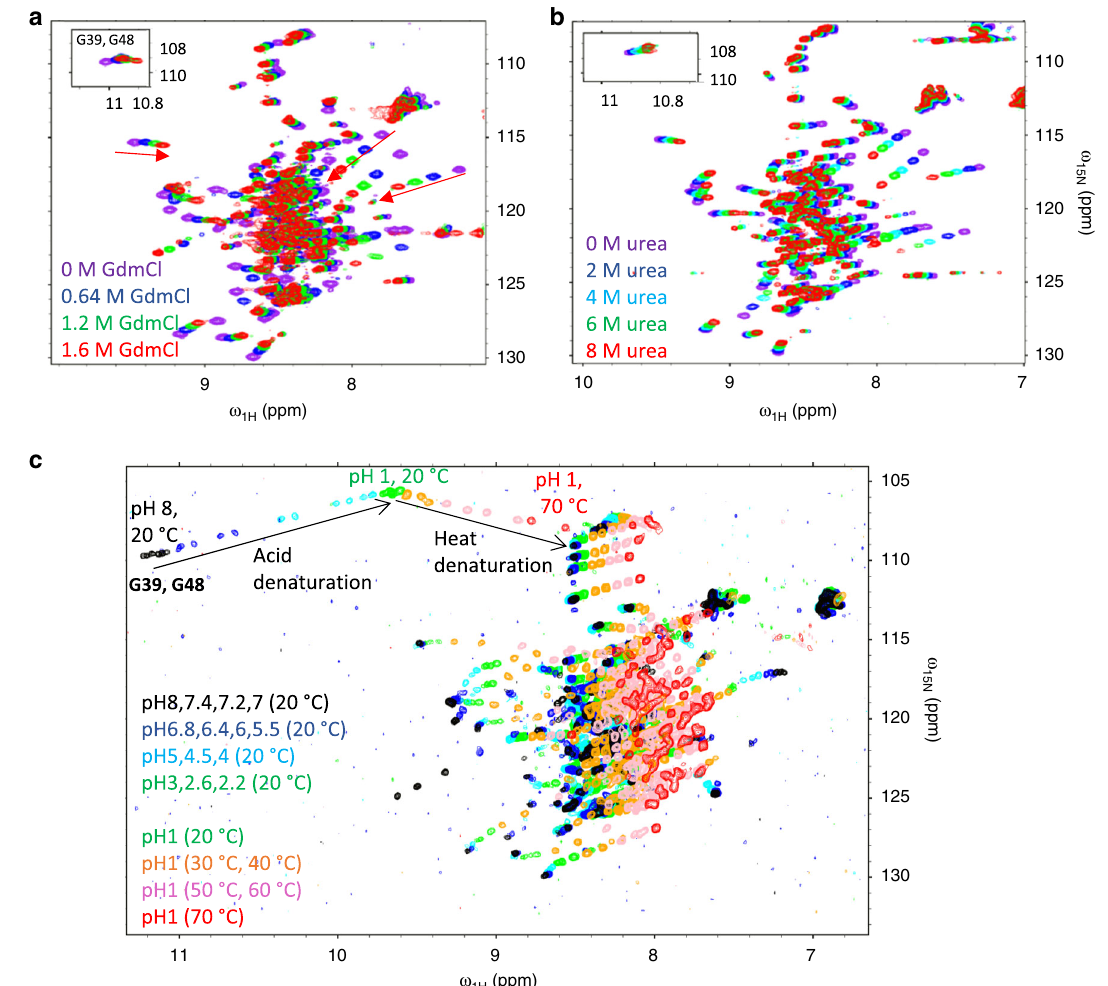
Fig. 1 Chemical, acid, and thermal denaturation of fi ve-phospho 4E-BP2. a Overlay of NMR 15 N – 1 H HSQC spectra of 5p-4E-BP2 GdmCl titration samples at pH 6.0 and 20 °C. b Overlay of NMR 15 N – 1 H HSQC spectra of 5p-4E-BP2 urea titration samples at pH 6.0 and 20 °C. Insets to a and b panels contain the down fi eld portion of the spectrum with resonances of G39 and G48. c Acid and thermal denaturation of 5p-4E-BP2. The acid denaturation data shown were collected at 20 °C between pH 8.0 and pH 1.0 (spectra colored in gradient from black to green). Thermal denaturation at pH 1.0 is shown for temperatures between 20 and 70 °C (gradient from green to red). The two arrows in the upper left corner of the spectrum show the trajectories of the G39 and G48 resonances for acid and heat denaturation. The peaks on the upper right of the urea spectra b are aliased 4E-BP2 amide sidechain resonances, explaining their absence in a and c